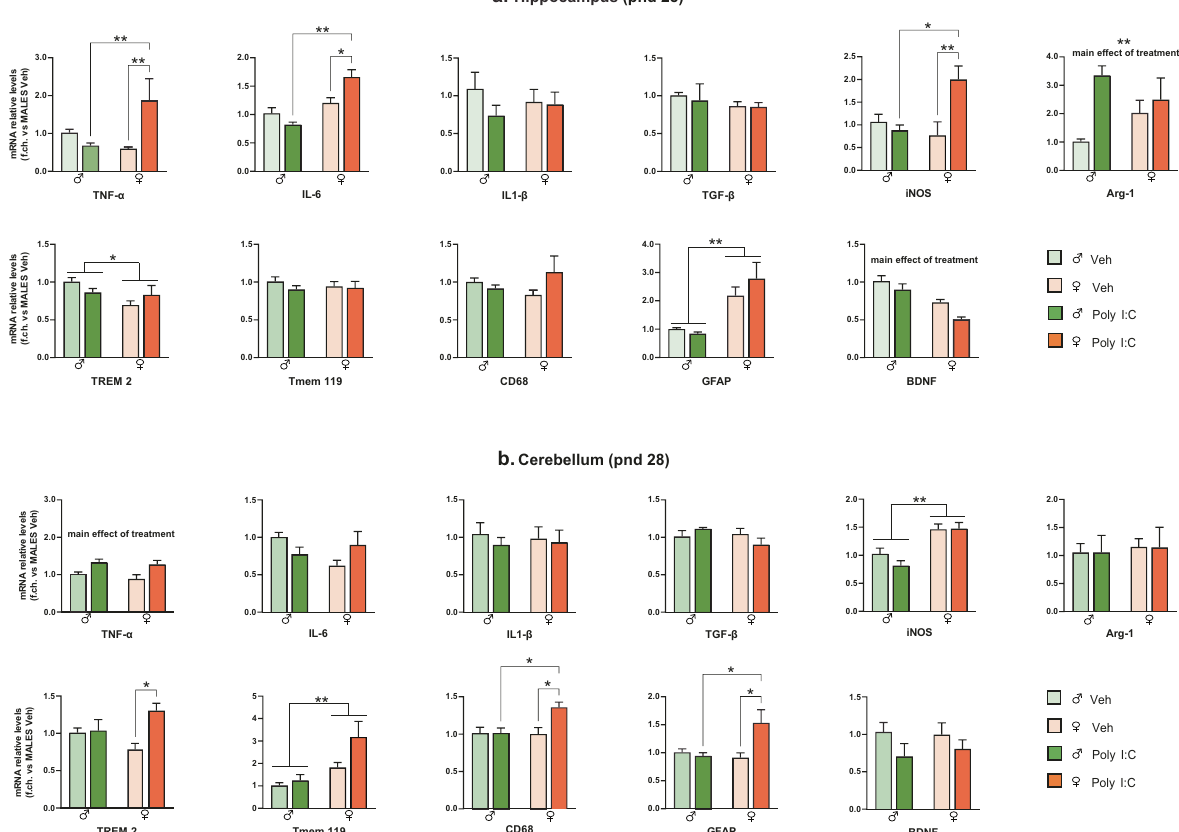
Fig. 2 MIA effect on neuroin fl ammatory pro fi le of offspring at pnd 28. mRNA levels in hippocampus ( a ) and cerebellum ( b ) were evaluated by RT-PCR using the 2 − ΔΔ Ct method, normalized to the housekeeping gene β -actin, and relative to Veh males ( n = 6 M/6 F per group). Data are expressed as means ± S.E.M. Two-way ANOVA with post-hoc Tukey ’ s test, * p < 0.05; ** p < cerebellar contribution in higher functions such as emotional, social and cognitive processing [29, 30]. Basal expression of these genes, as well as their regulation by prenatal Poly I:C exposure, were largely sex-, age- and brain region-speci fi c. In the hippocampus at pnd 28 (Fig. 2a), Poly I:C induced a strong increase of TNF- α [treatment*sex: F(1,17) = 13.4, p < 0.05, p < 0.01 vs Veh females and Poly I:C males], IL-6 [treatment*sex: F(1,16) = 11.66, p < 0.01, p < 0.05 vs Veh females and p < 0.01 vs Poly I:C males] and iNOS [treatment*sex: F(1.19) = 8.495, p < 0.01, p < 0.01 vs Veh females and p < 0.05 vs Poly I:C males] only in females. In addition, Poly I:C decreased BDNF and increased Arg-1 in the offspring of both sexes [main effect of treatment F(1,18) = 9.225, p < 0.01 for BDNF and F(1,17) = 6.805, p < 0.05 for Arg-1]. The other mRNAs analyzed (IL-1 β , TGF- β , TREM2, Tmem119, CD68, and GFAP) were not altered by prenatal Poly I:C administration. However, expression of some of these genes were sex-speci fi c: females, regardless of prenatal treatment, expressed lower TREM2 and higher GFAP levels compared to males [main effect of sex: F(1,20) = 4.870, p < 0.05, F(1,18) = 9.225, p < 0.01, respectively]. In the cerebellum (pnd 28, Fig. 2b), Poly I:C increased the expression of TREM2 [treatment*sex: F(1,18) = 5.258, p < 0.05, p < 0.05 vs Veh females], CD68 [treatment*sex: F(1,18) = 5.277, p < 0.05, p < 0.05 vs Veh females and Poly I:C males] and GFAP [treatment*sex: F(1,17) = 7.375, p < 0.05, p < 0.05 vs Veh females and Poly I:C males] only in females. Moreover, Poly I:C upregulated TNF − α mRNA levels [main effect of treatment F(1,16) = 13.14, p = 0.002] in offspring of both sexes. Females,